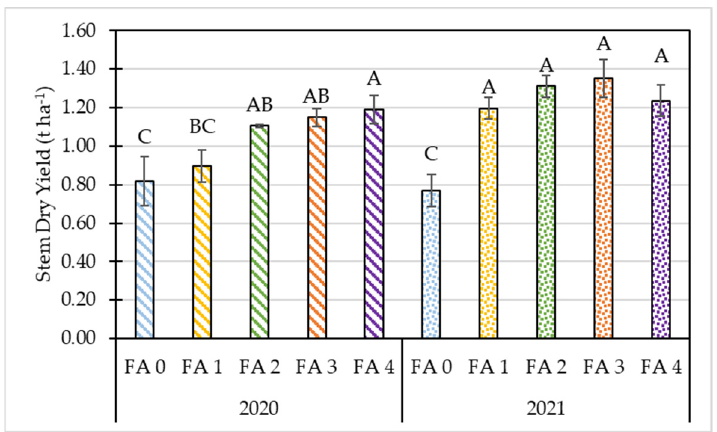
Figure 5. Influence of interaction Y × FA on stem dry yield. FA0: only water; FA1: 8 g L − 1 of CaO; FA2: 12 g L − 1 of CaO; FA3: 8 g L − 1 of CaO + 16 g L − 1 of urea; FA4: 12 g L − 1 of CaO + 16 g L − 1 of urea. Values with different letters are significantly different at p ≤ 0.05 according to Tukey’s test. Bars represent the standard deviation. ₋